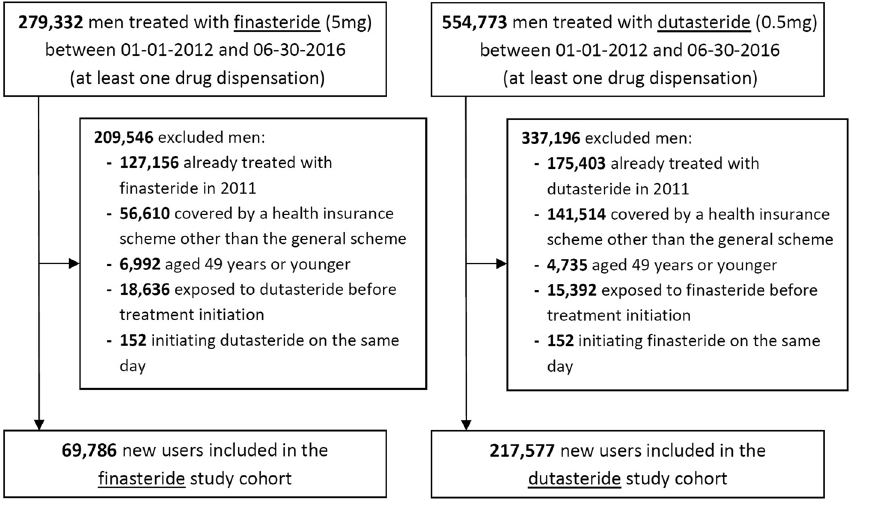
Figure 1. Study flow